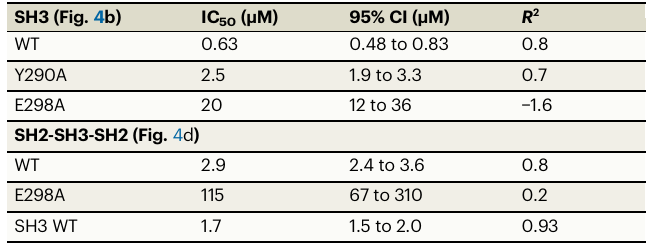
Top:p120RasGAPSH3domainandmutants.TheY290AandE298AmutantshaveincreasedIC 50 values relative to the wildtype. Negative R 2 value for E298A indicates ineffectiveinhibition. Bottom:p120RasGAP SH2-SH3-SH2 domains compared to SH3 domain. All valuesarecalcu- latedusingGraphPad (GraphPad